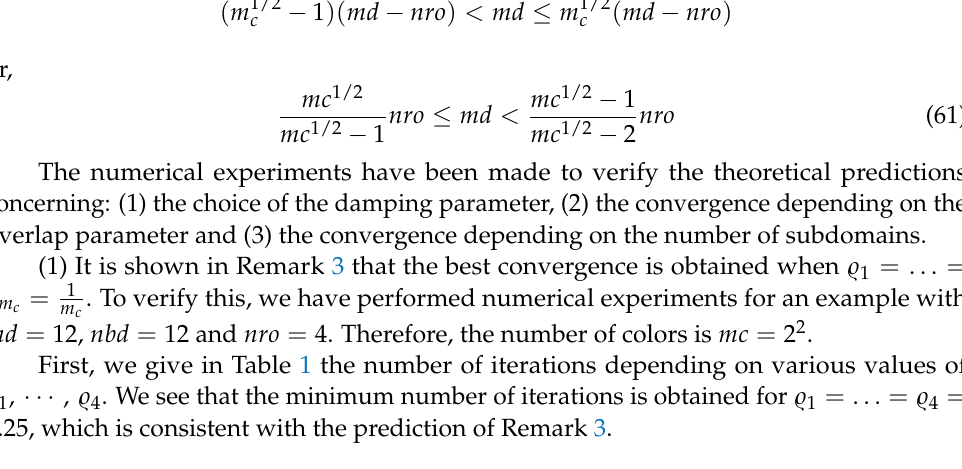
Table 1. Number of iterations depending on the various damping parameters associated with the